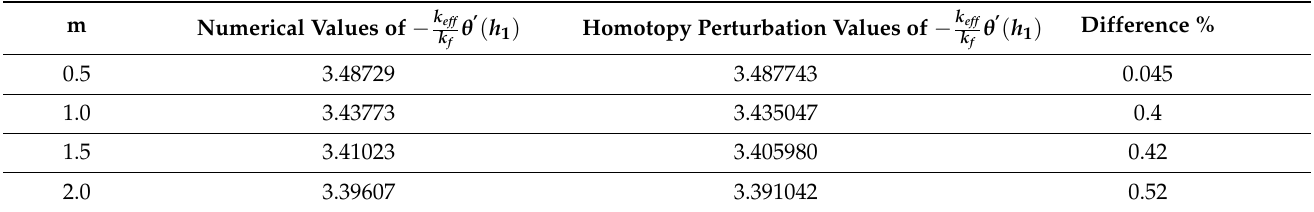
Table 3. Heat transfer rate at the upper boundary by changing Hall parameter, where γ = π α = π , η = 0.8, a = 0.6, d = 0.7, b = 0.5, x = 0, Br = 0.2, k = 2, Gr = 2, φ = 0.05, ∈ = 2, M = 1. 4